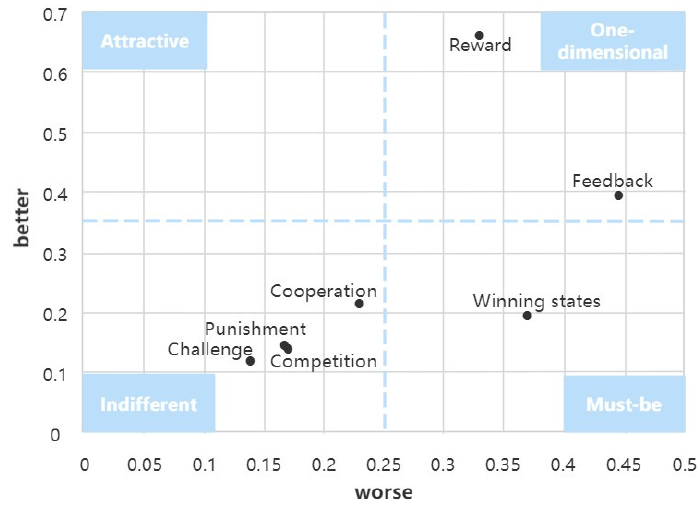
Figure 3. Quartile chart: Better–worse coefficient analysis.